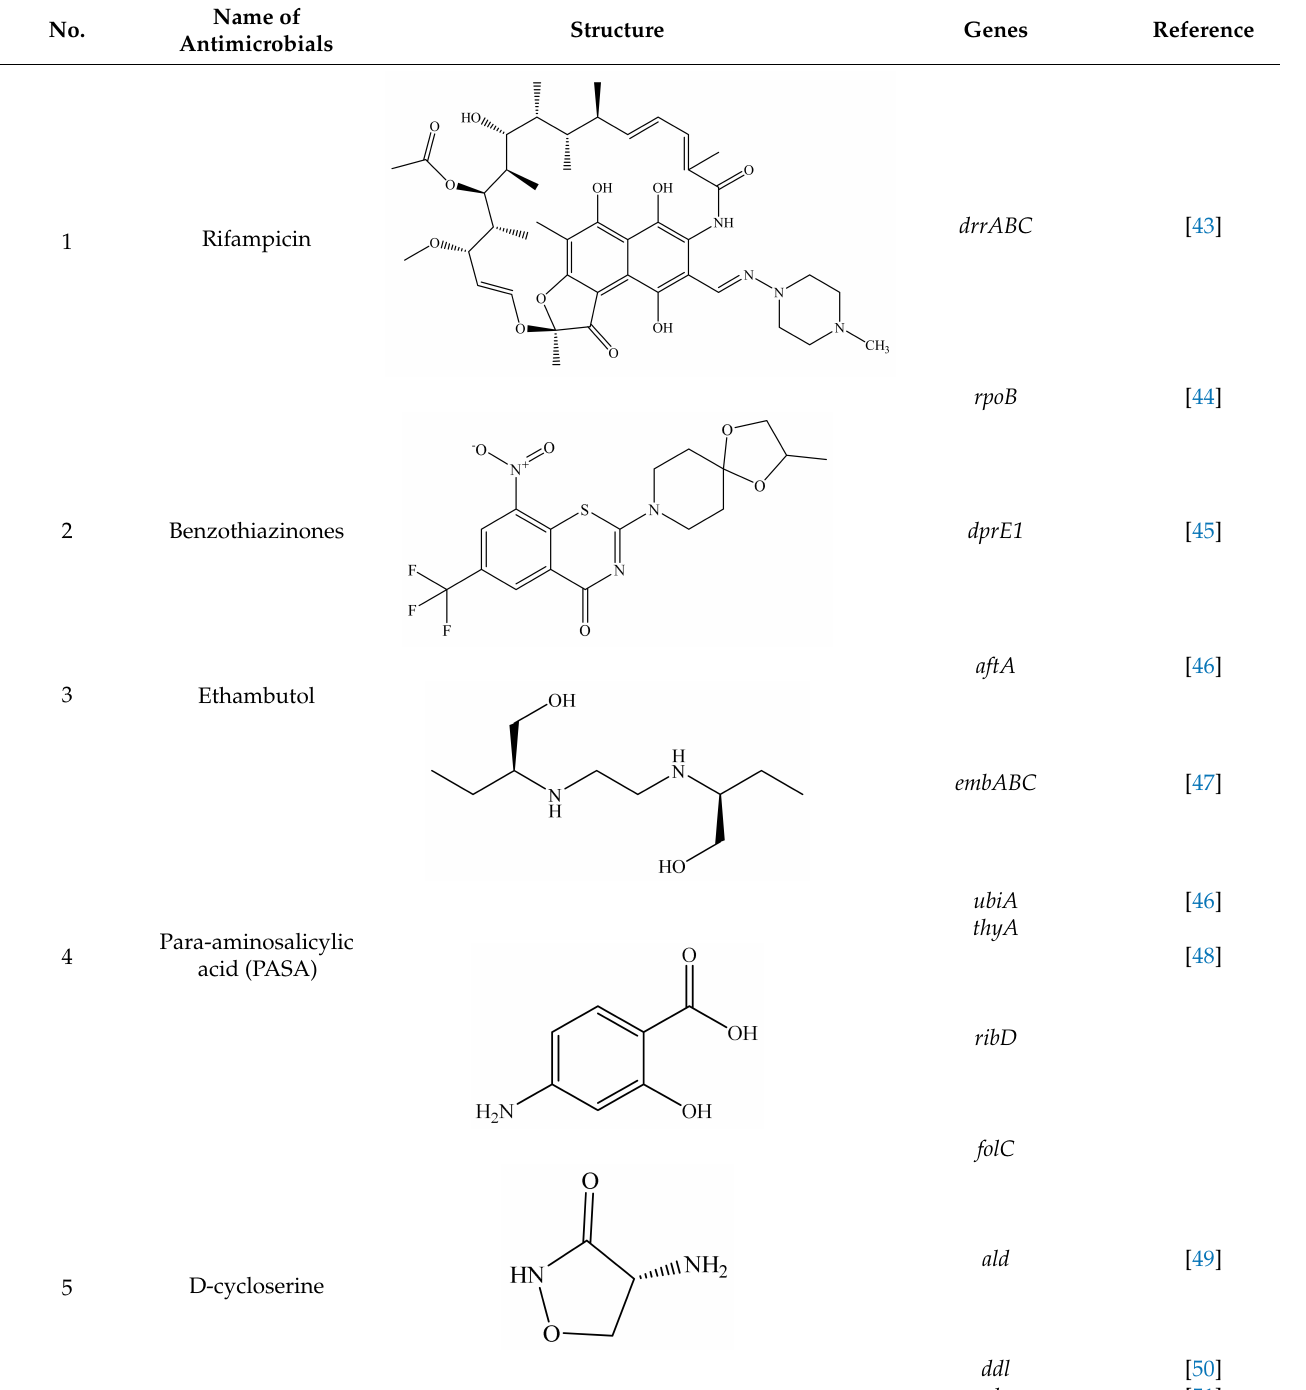
Table 2. Antimicrobials and the associated genes that confer resistance to those antimicrobials.